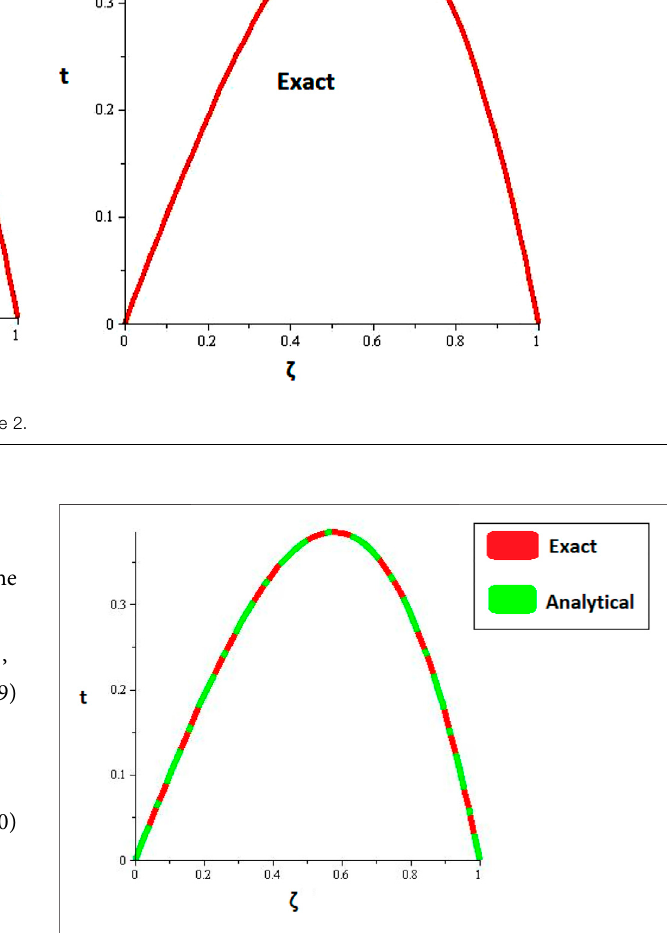
FIGURE 7 | Comparison for the exact and analytical solution at γ =1 for Example